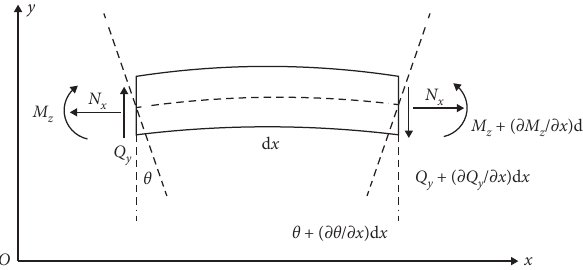
Figure 1: Cable balance